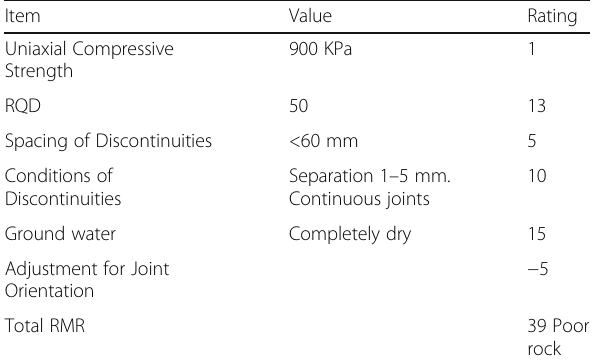
Table 4 RMR value for the KV5 is determined as